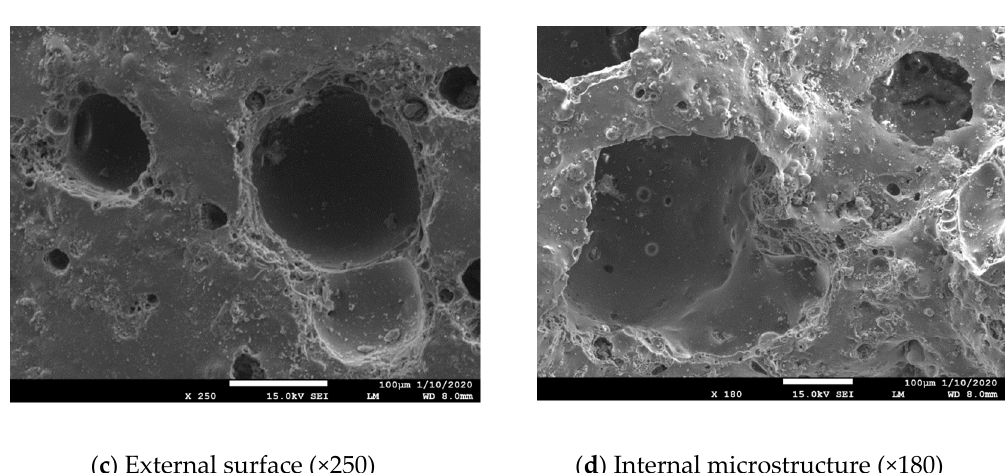
Table 3. Mixture proportions of concrete.